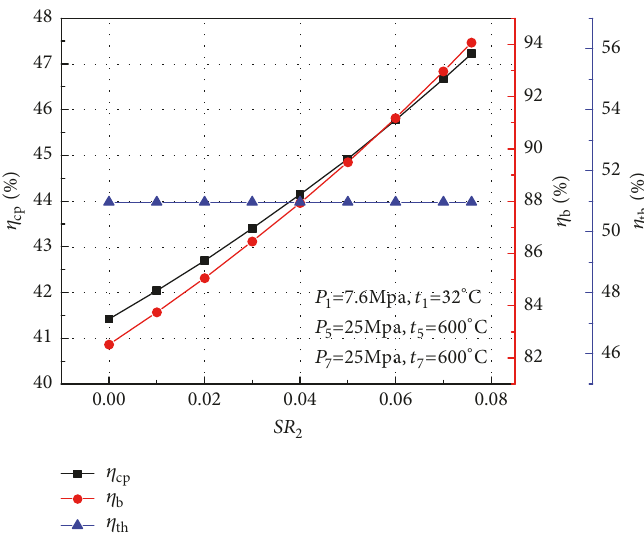
Figure 6: Effects of SR 2 on boiler efficiency, thermal efficiency, and net